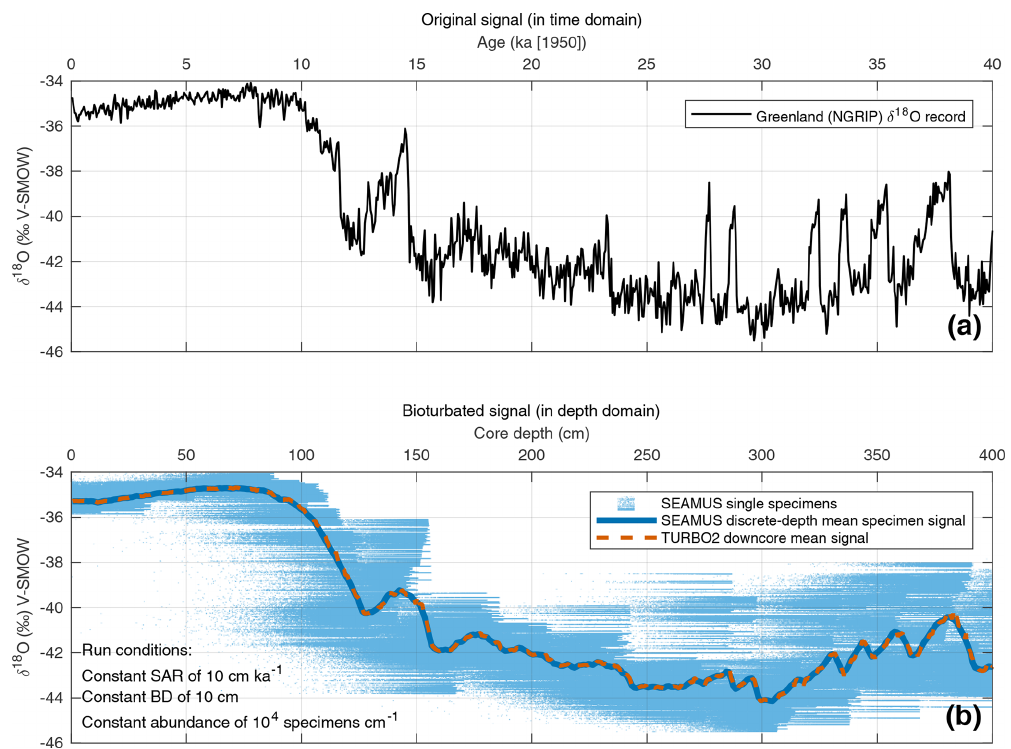
Figure 1. (a) NGRIP δ 18 O record (North Greenland Ice Core Project members, 2004) plotted using the latest GICC05 timescale (Rasmussen et al., 2014; Seierstad et al., 2014), adjusted by 50 years so that 1950 CE is equivalent to “present”. (b) Result of SEAMUS run using the NGRIP δ 18 O data as temporal input data. SEAMUS run settings are shown in the panel inset. Also shown is the average of 10 runs of TURBO2 (Trauth, 2013), based on the same NGRIP input data and using a SAR of 10cmkyr − 1 and a constant BD of 10cm. Table 1. Approximate run times and memory use in MATLAB and Octave in the case of a 70kyr simulation run with 10-year iterations and sediment archive capacity of 10 2 , 10 3 and 10 4 specimens per centimetre depth. The runs were carried out on a 64-bit system (Ubuntu 18.04) with 16GB of RAM and an Intel i7-2600 processor, using MATLAB 2019a or Octave 5.1.0. Reported memory use is the additional memory load on the system (rounded up to the nearest 10Mb) while running the simulations (i.e. excluding the general background memory use by MATLAB or